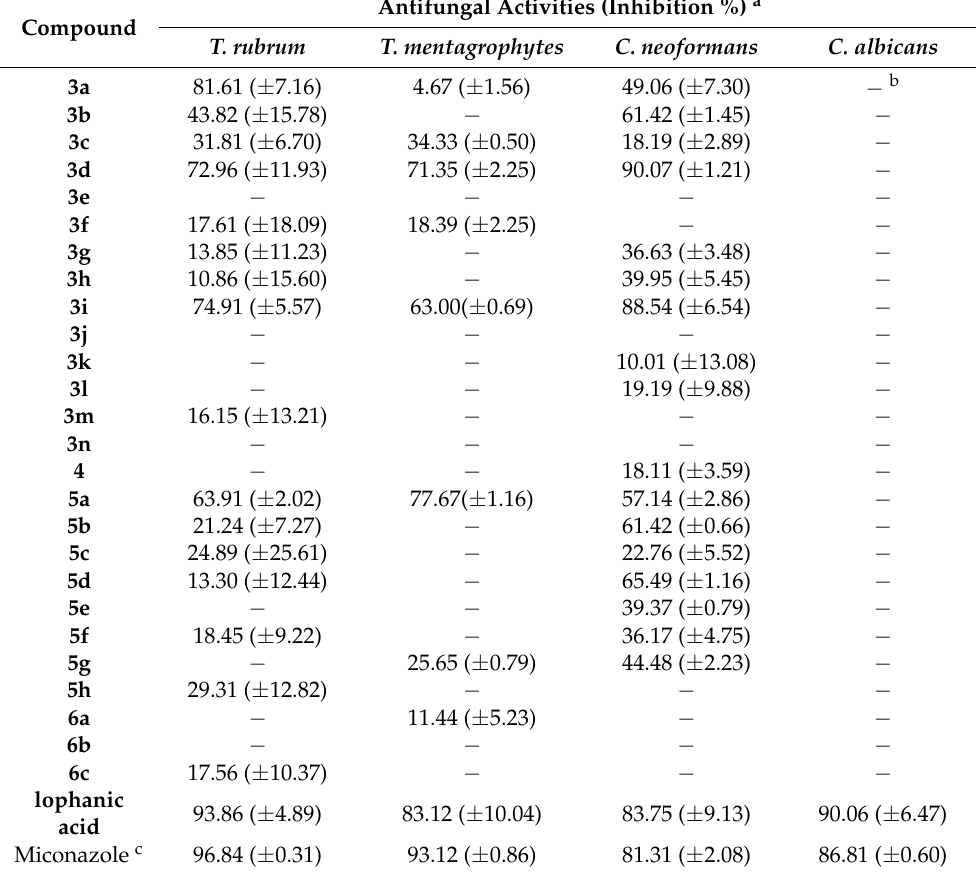
Figure 3. X-ray crystallographic structure of 6a . Table 1. Antifungal activities of compounds 3a – 6c at 100 µ